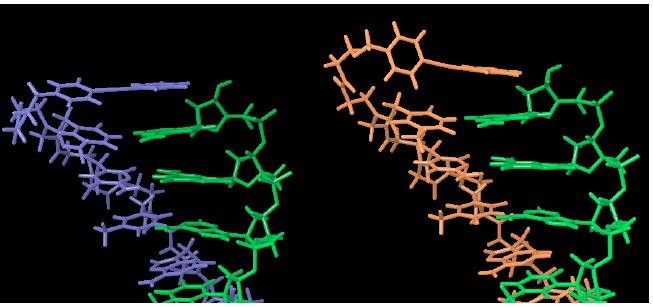
Figure 3. Molecular docking simulation of the tolane-PNA / DNA duplex conformation. Left: tolane 6 in PNA forms a favorable stacking conformation with the terminal base pair of the PNA / DNA duplex via its flexible ether linker. Right: tolane 8 in PNA forms a stacking interaction with the DNA bases, but not with the terminal base of the PNA due to the rigidity of the amide backbone. The PNA / DNA duplex structures were obtained as 1PDT from the PDB data bank and the conformational search was performed using the force field OPLS2005 model and MacroModel. Green; DNA, Blue; PNA conjugated with tolane 6 , Orange; PNA conjugated with tolane 8